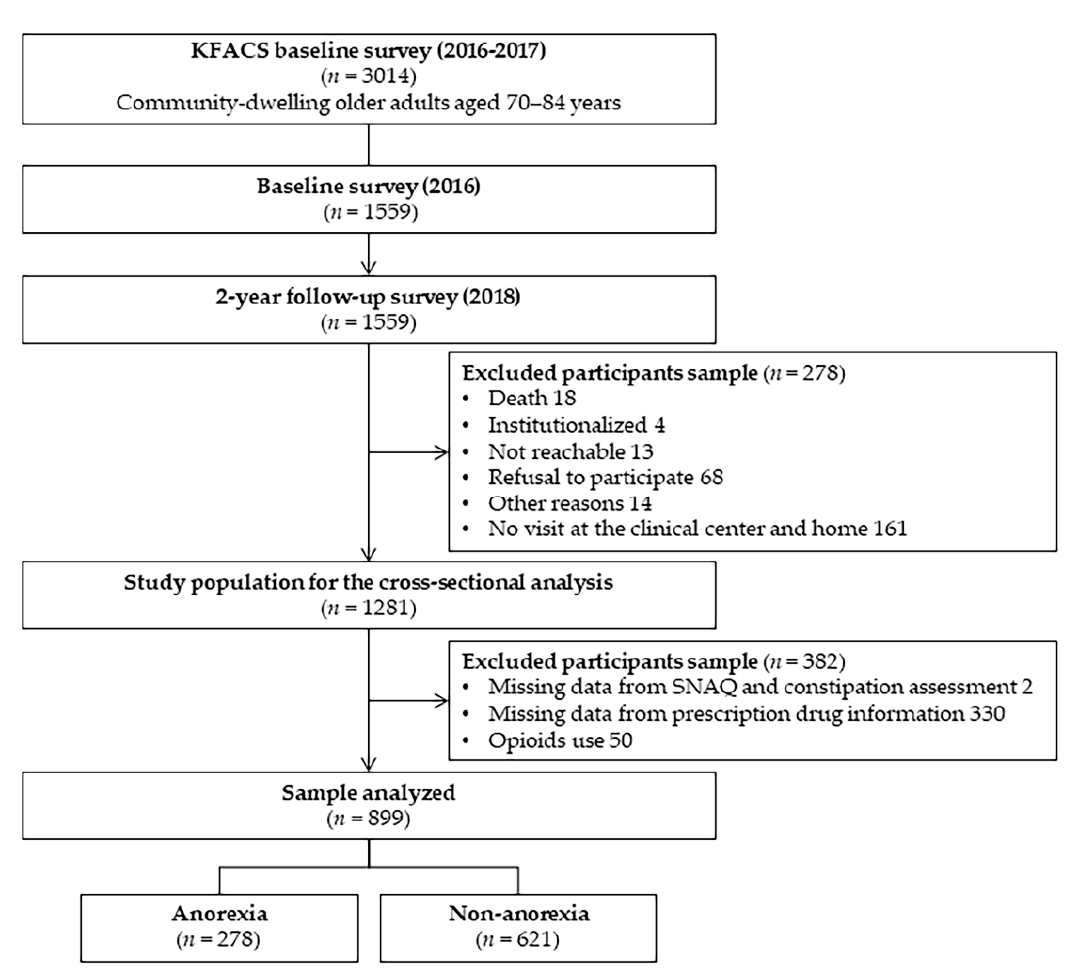
Figure 1. Flow chart of the study population.